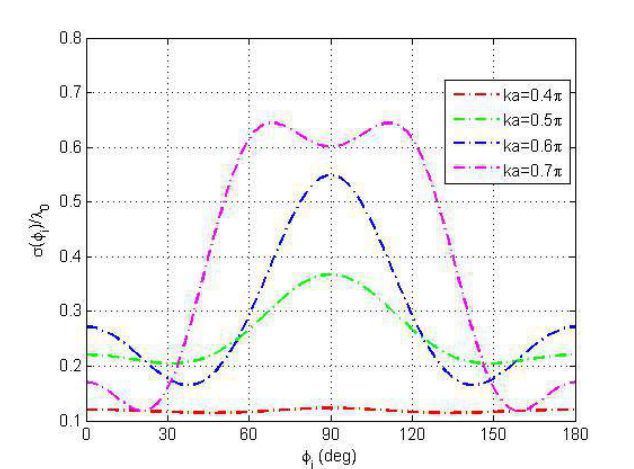
Figure 7: Variation of the normalized backscattering width with the incident angle for gyroelectric elliptic cylinders of axial ratio 2 and 4 different values of 𝑘 𝜀 !! = −𝑗2 , 𝜇 !! = 2, when excited via a TE polarized plane